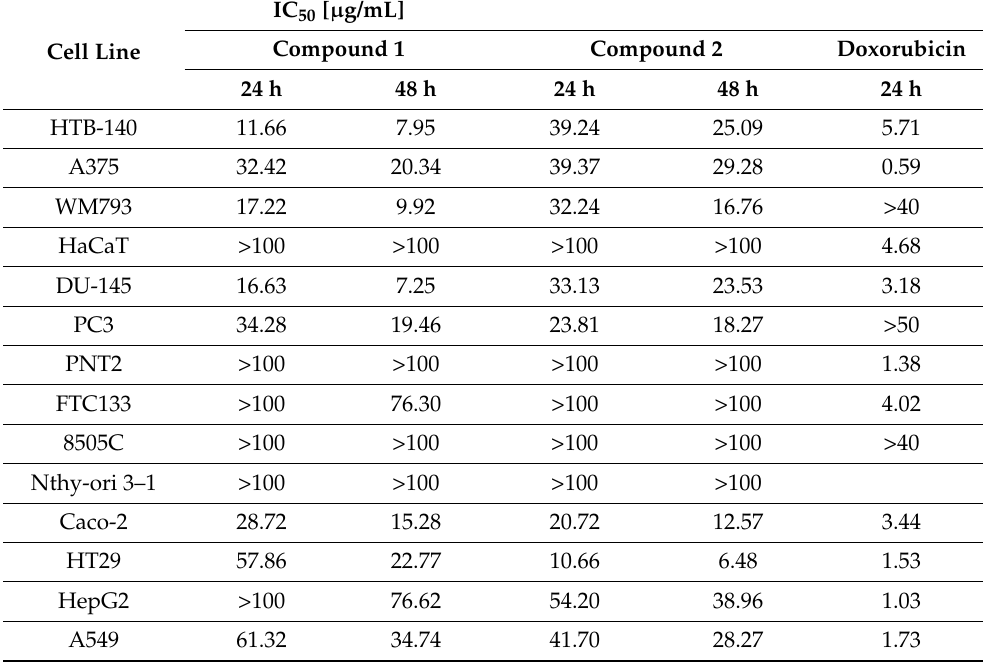
Table 2. Cytotoxicity of serjanic acid glycosides 1 and 2 isolated from Chenopodium hybridum